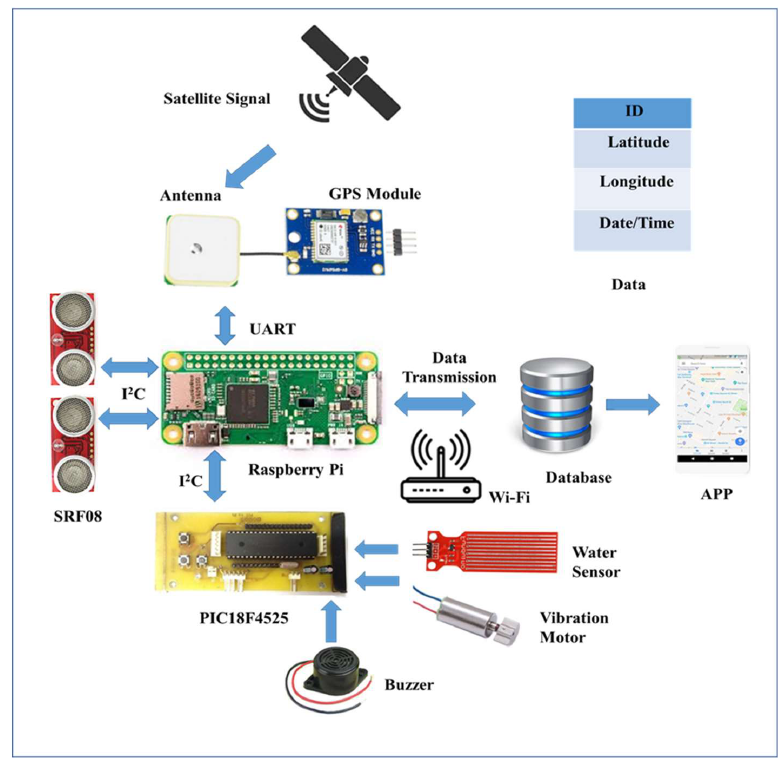
Figure 1. Proposed system architecture. Table 1. Comparison between Raspberry-Pi, the PIC microcontroller, and Arduino [18–20,23].